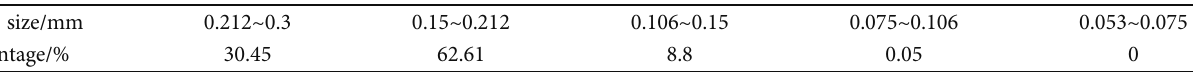
Figure 2: Real-time X-ray CT-aided C-T test apparatus. Table 1: Grain size composition.